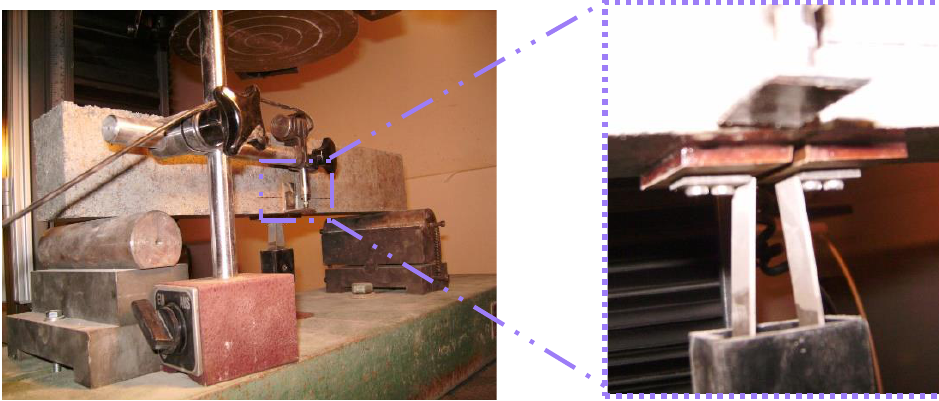
Figure 2. Experimental setup for CMOD controlled three-point bending test. Table 3. Dimensions of sample and central notch